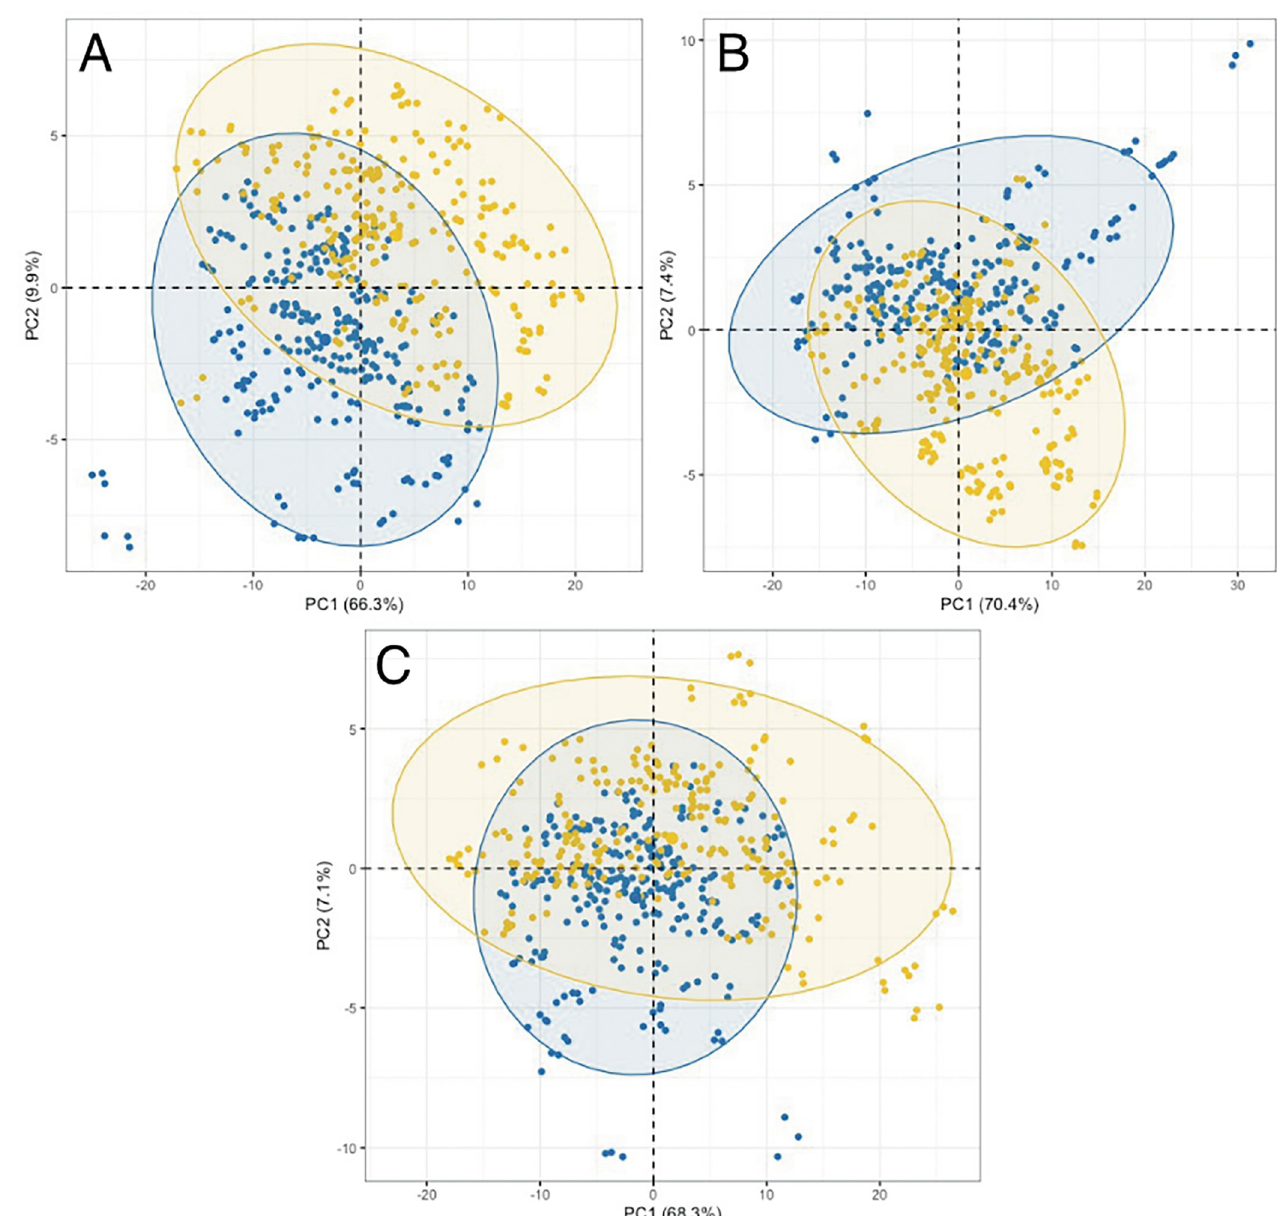
Fig 2. Principal component analysis scores plots for the unfiltered whole serum of the first and second dimensions. The three figures represent (A) GBM in blue and non-cancer in yellow, (B) lymphoma in blue and non-cancer in yellow and (C) GBM in blue and lymphoma in yellow. The eclipses in each class represent a 95% confidence interval. Values in parentheses within the axes legends are the total explained variance (TEV) for each principal component (PC). https://doi.org/10.1371/journal.pone.0279669.g002 versus non-cancer (Fig 4B) has similar reliance on the Amide I and Amide II bands, however there is less importance in the glycogen/carbohydrates. The peak at ~1740 cm -1 suggests that the discrimination between lymphoma and non-cancer is also determined by the lipid compo- nents within the serum. Discriminating between cancer types, GBM versus lymphoma (Fig 4C), there is importance within the Amide I and Amide II region, and the glycogen/carbo- hydrates region. The peaks identified as important for each group is displayed in Table 4.